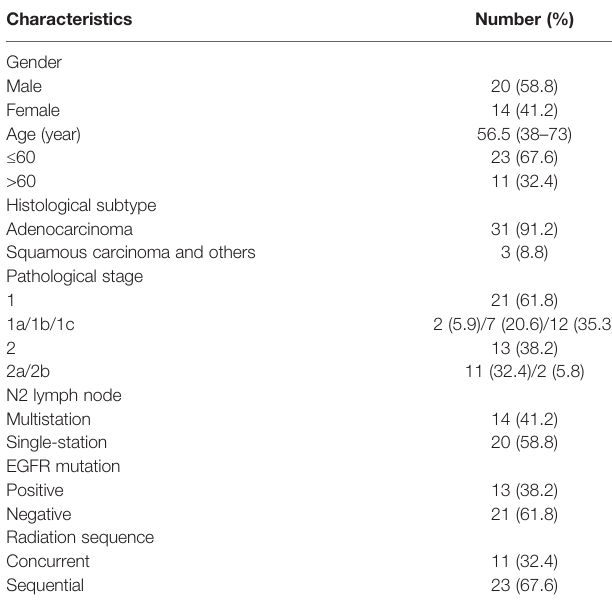
TABLE 1 | Baseline characteristics of all patients